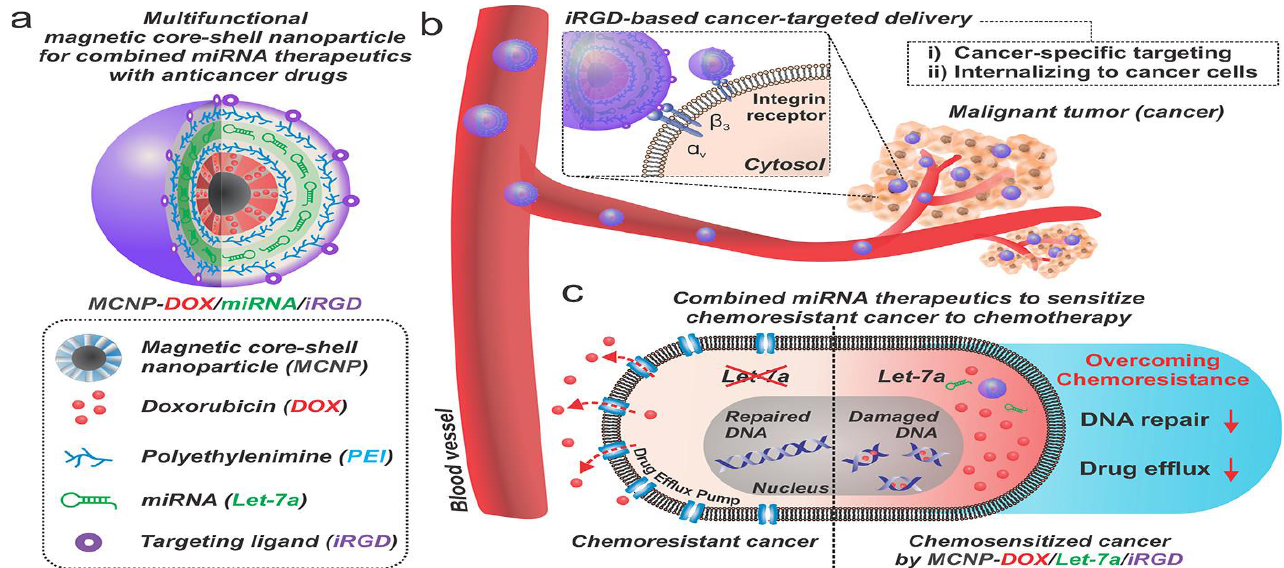
Figure 3. Multifunctional magnetic nanoparticles for co-delivery of miRNA-let7a and doxorubicin to improve therapeutic response and overcome drug resistance [77]. Copyright © 2018, American Chemical Society. ( a ) Design of the MCNP construct for simultaneous delivery of miRNA and anticancer drugs (e.g., DOX).; ( b ) MCNP construct is decorated with iRGD peptide, enabling the tumor-targeted delivery via α V β 3 integrin-mediated uptake. ( c ) Co-delivery of miRNA (let-7a) sensitizes cancer cells to DOX therapy via inhibition of multiple chemoresistance-related genes, including those associated in drug efflux and DNA repair